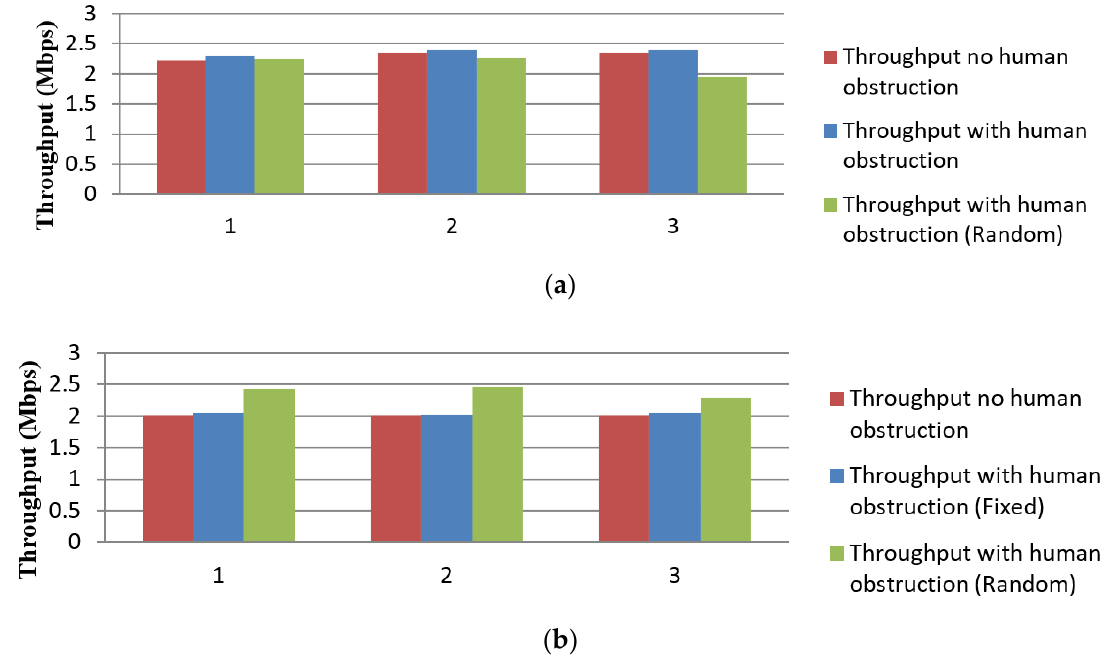
Figure 8. Performance results for the office environment. ( a ) Office WT211; ( b ) Office WT210.